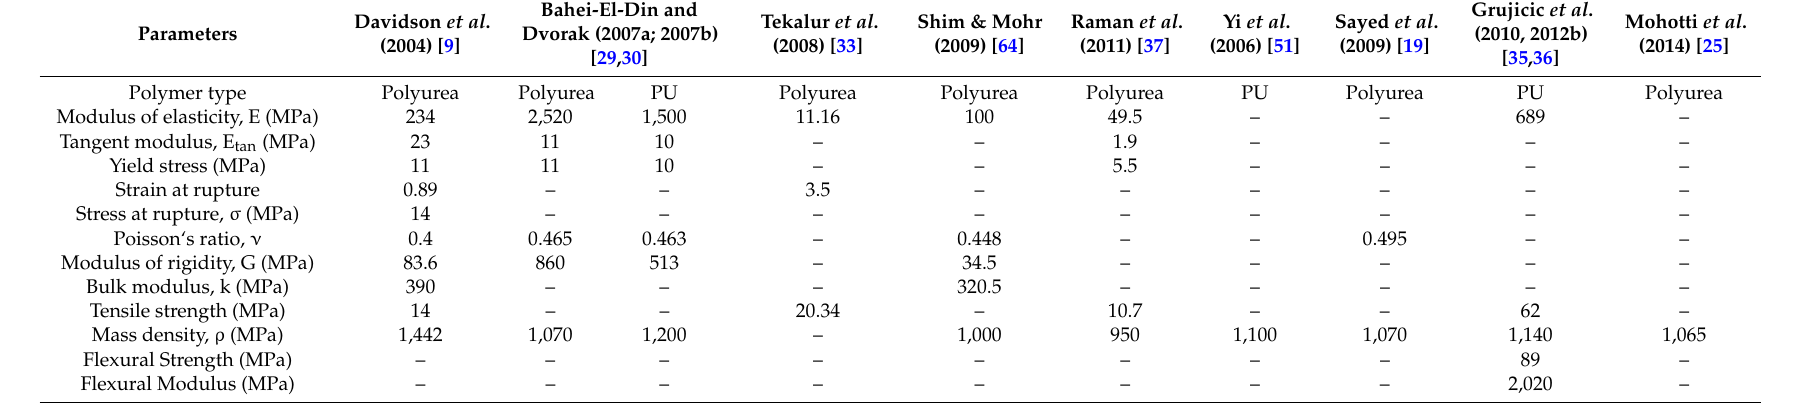
Table 1. Mechanical and physical properties of selected elastomeric polymers (PU and polyurea) in the quasi-static